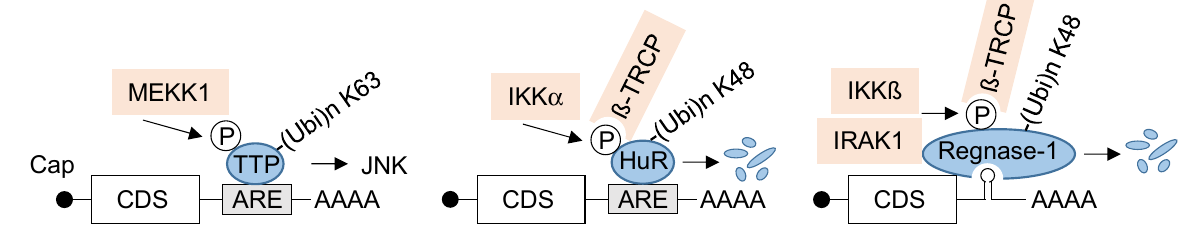
Figure 2. Regulation of mRNAs by RNA-binding proteins. The RNA-binding proteins are depicted in blue, and regulators of the NF- κ B pathway are shown in light red; the consequences of the signal-regulated modifications of RBPs are indicated.